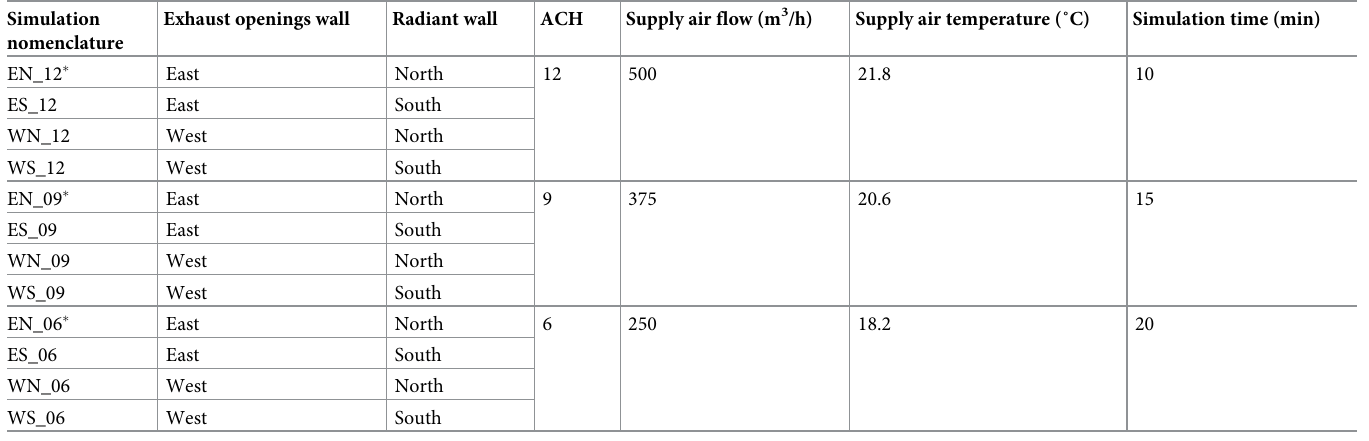
Table 1. Conditions of the CFD test